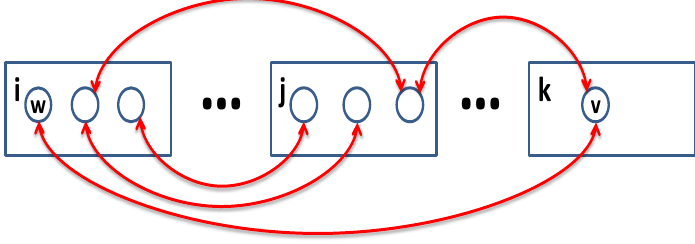
Figure 5. A repair scenario with colour classes i, j and